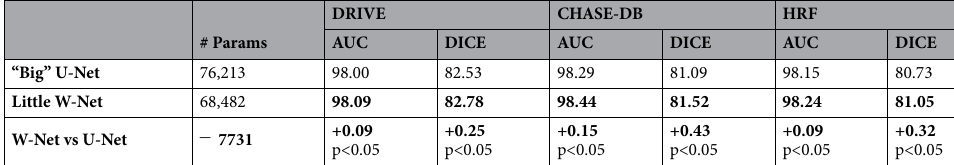
Table 8. Performance comparison between a W-Net and a U-Net configured to have a comparable amount of weights. W-Net achieves higher performance, despite having slightly less parameters. Statistically significant results marked bold.